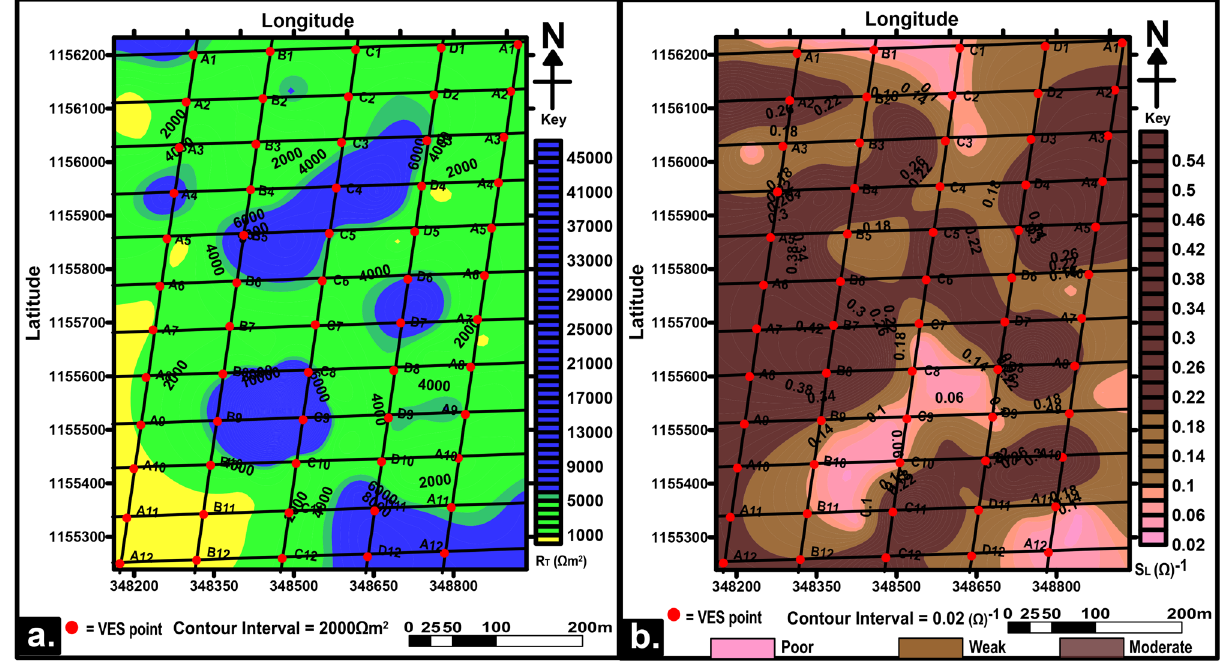
Fig. 7 Aquifer potential and protective Index parameters showing a the transverse resistance and b the longitudinal